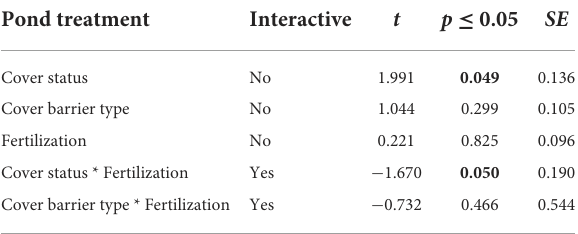
TABLE 1 Results of generalized quasi-Poisson linear models for separate and interactive influences of various pond treatment effects on bird encounter